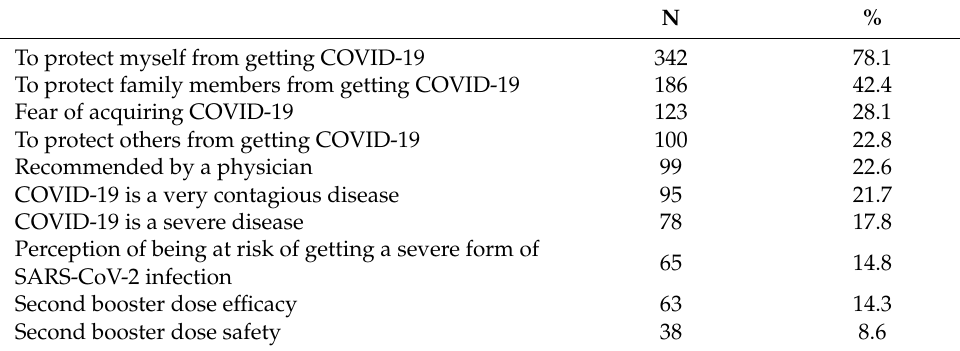
Table 3. Reported reasons for receiving the second booster dose of the COVID-19